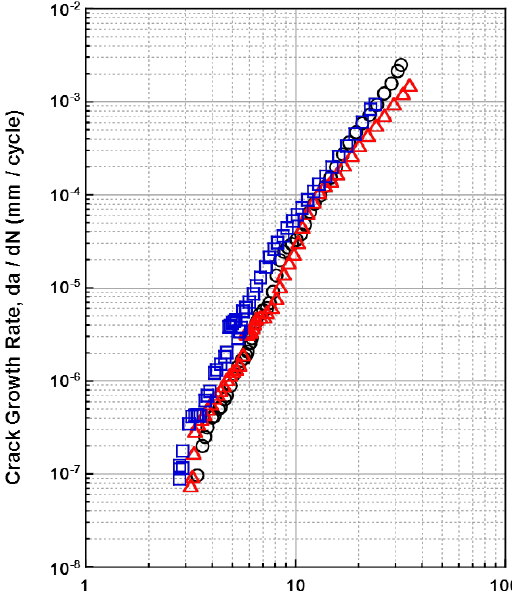
Figure 16. Effects of heat treatment on fatigue crack growth rate obtained by fatigue crack growth test of β -annealed an d α - β -forged Ti-15Zr-4Nb-4Ta alloys in